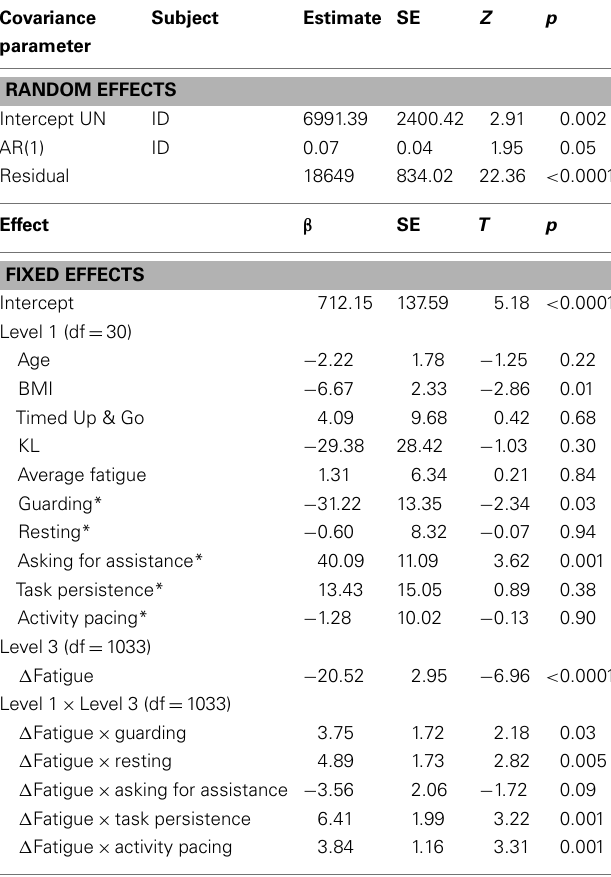
Table 5 | Multilevel model results predicting momentary activity from interaction terms including coping subscales and